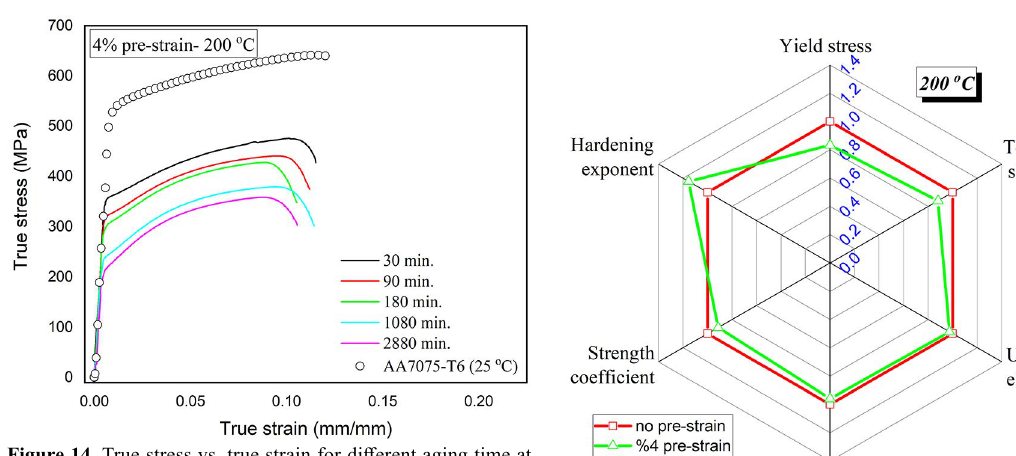
Figure 16. Comparison of mechanical properties at 160 ºC